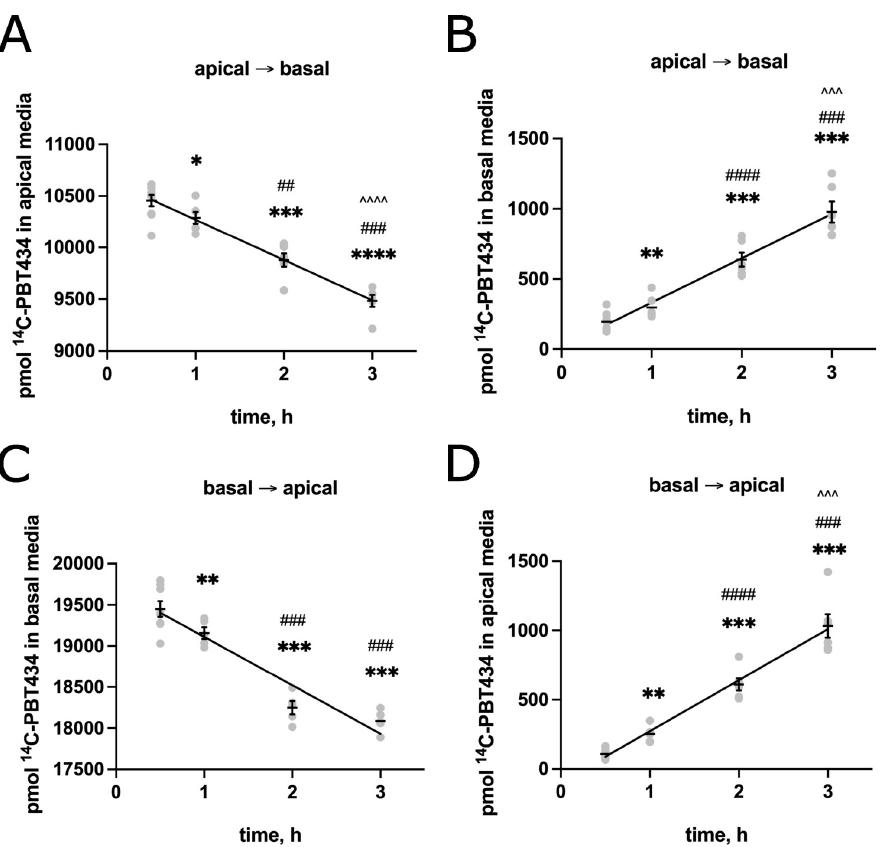
Fig 4. 14 C-PBT434 fluxes across an hBMVEC transwell model of the blood-brain barrier. hBMVEC grown in the apical chamber of Transwell Thincerts ™ were loaded with 20 μ M 14 C-PBT434 in the apical chamber, and the mass of 14 C-PBT434 in both the apical ( A ) and basal (B ) chamber was quantified over 3h. Data are represented as mean ± SEM, n = 6–9 experimental replicates/time point. Statistical significance was determined using one-way ANOVA and Tukey’s multiple comparison test. � , statistically significantly different from 0.5h; �� , p < 0.01; ��� , p < 0.001; ���� , p < 0.0001; #, difference from 1h; #, p < 0.05; ###, p < 0.001; ####, p < 0.0001; ^, difference from 2h; ^^, p < 0.01; ^^^^, p < 0.0001. hBMVEC grown in the apical chamber of Transwell Thincerts ™ were loaded with 20 μ M 14 C-PBT434 in the basal chamber, and the mass of 14 C-PBT434 in both the apical ( C ) and basal ( D ) chamber was quantified over 3h. Data are represented as mean ± SEM, n = 4–9 experimental replicates/time point. Statistical significance was determined using one-way ANOVA and Tukey’s multiple comparison test. � , statistically significantly different from 0.5h; �� , p < 0.01; ��� , p < 0.001; ���� , p < 0.0001; #, difference from 1h; #, p < 0.05; ###, p < 0.001; ####, p < 0.0001; ^, difference from 2h; ^^, p < 0.01; ^^^^, p < 0.0001. Rates of 14 C-PBT434 uptake or efflux were calculated using linear regression analysis. Note: the volume of the apical media is 0.5 ml compared to 1 ml of basal media.